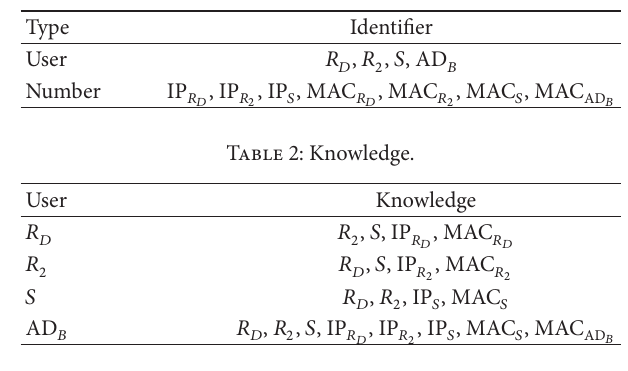
Table 1: Identifiers.